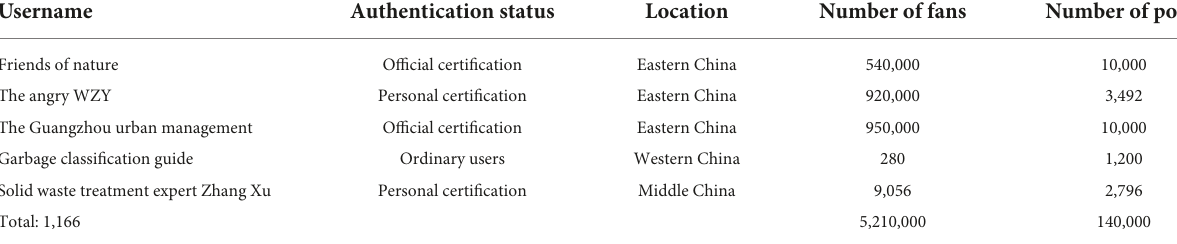
TABLE 1 The users’